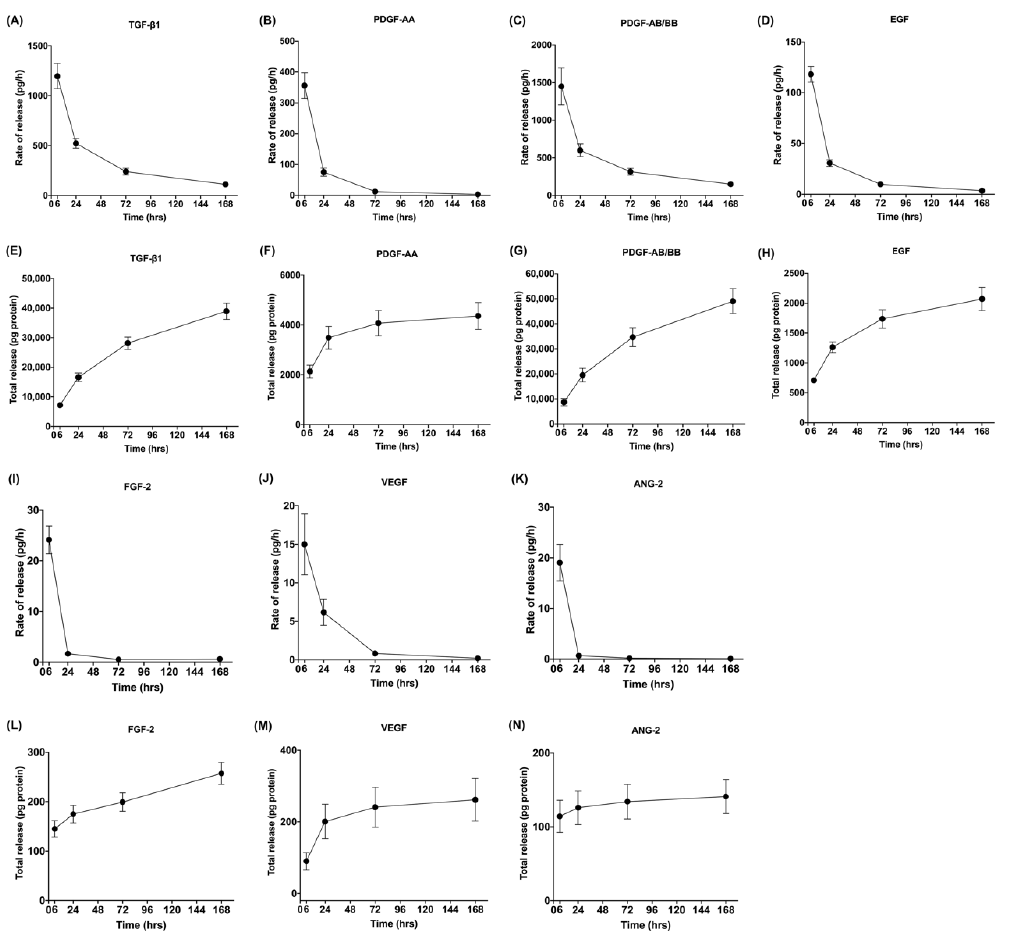
Figure 2. Rate of release and total release of GFs. The figure shows the rate of release and total release of the tested GFs from the L-PRF membrane up to 168 h. Panels ( A , E ) display TGF- β 1, ( B , F ) PDGF-AA, ( C , G ) PDGF-AB/BB, ( D , H ) FGF-2, ( I , L ) EGF, ( J , M ) VEGF, and ( K , N ) ANG-2 for rate of release and total release, respectively. Mean ± SEM is displayed at each time point.